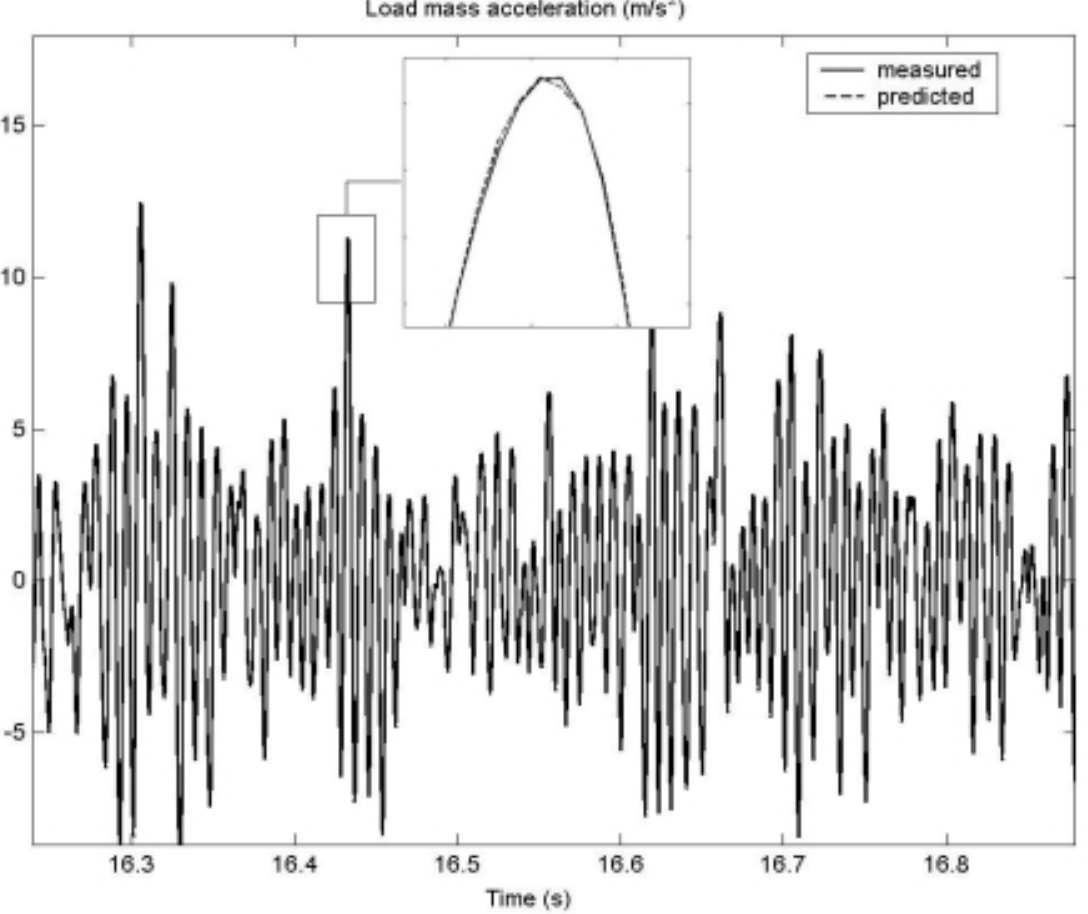
Fig. 8. Experimental measurement (solid line) and prediction (dashed line). A zoom is also shown to put in evidence the excellent